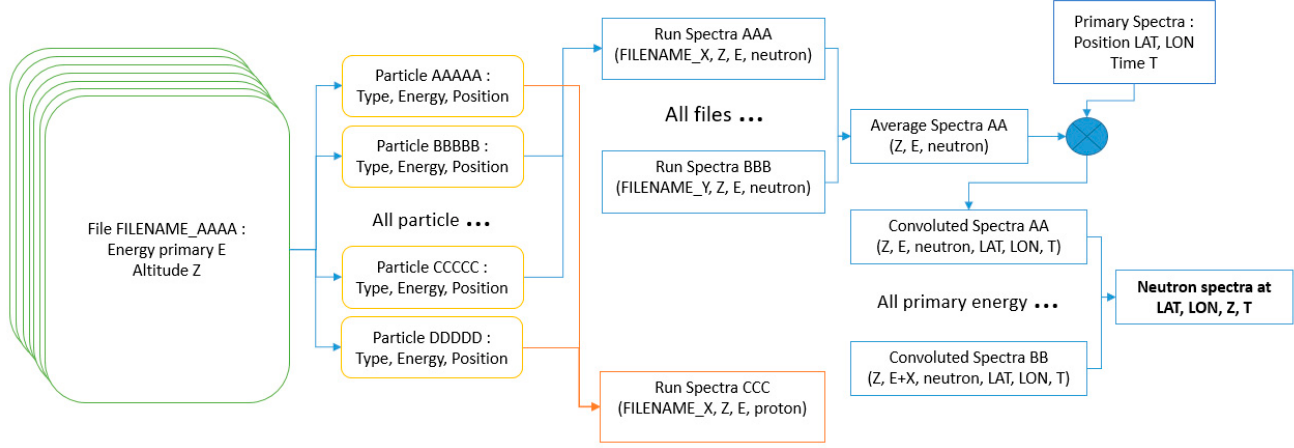
Figure 4. Schematic of the extraction of spectra at an altitude Z from the file of simulated data on the cluster to the user spectra of neutron based on the primary spectra at LAT , LON at the time T .